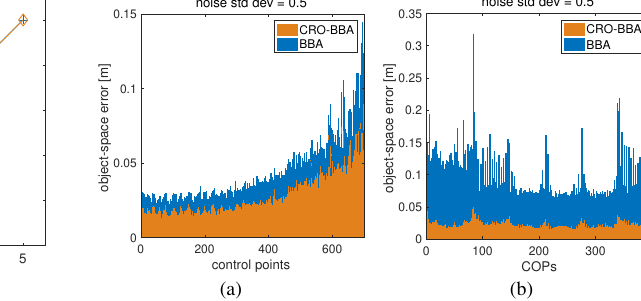
Figure 4. Image-space errors: RMS of the residuals and Root of Reference Variance (RRV) for BBA and CRO-BBA vs image noise. RRV is equal to the standard deviation of the image noise.